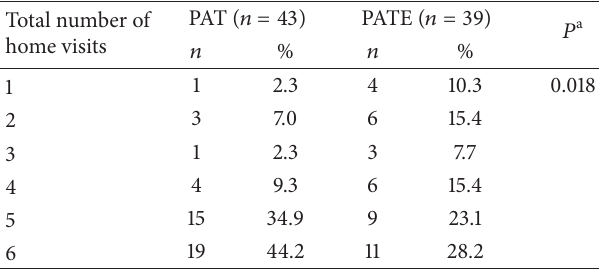
Table 2: Delta Healthy Sprouts participant compliance with home visits in the gestational period by